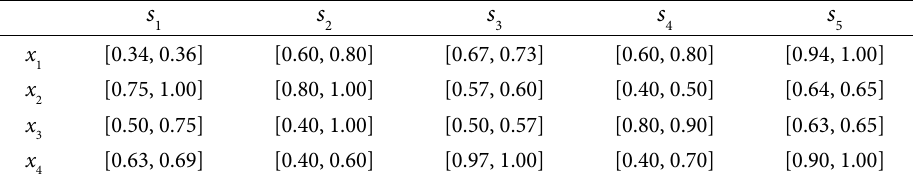
Table 7. Normalized uncertain decision matrix